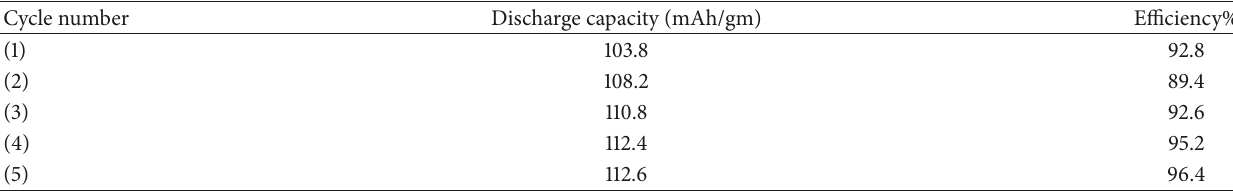
Table 1: Discharge capacity and efficiency for graphite.